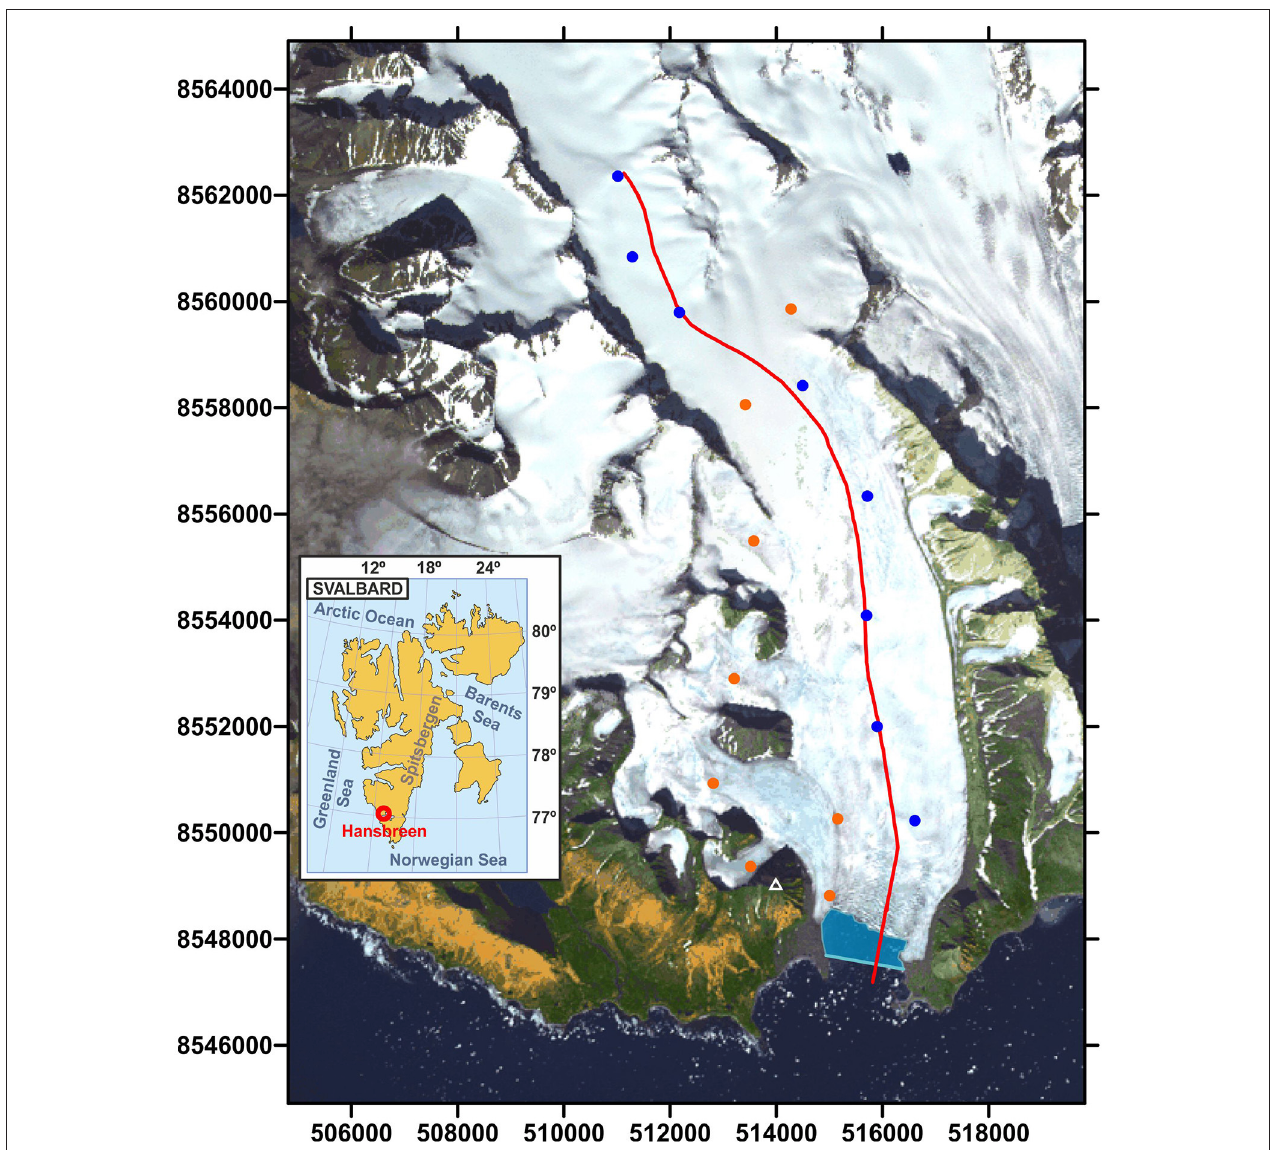
FIGURE 1 | Location of Hansbreen in Spitsbergen, Svalbard (inset). ASTER image of Hansbreen taken in 2011 showing the location of the modeled flowline (red line) and the locations of the stakes for velocity measurements (colored circles; the blue ones were used in this paper). The white triangle indicates the position of Fugleberget Peak. The blue polygon indicates the portion of open water over which the relative coverage of mélange/sea ice was quantified. UTM coordinates for zone 33X are included.